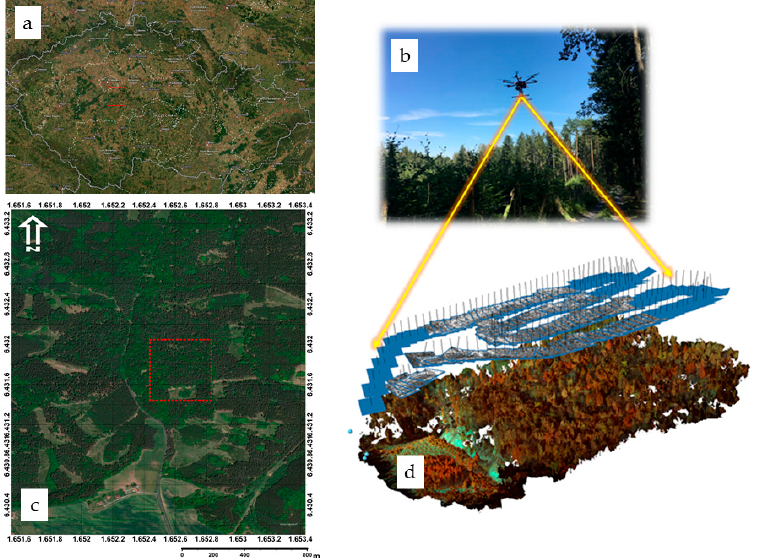
Figure 1. ( a ) Shows the relative location of the study area in the Czech Republic ( b ) the used unmanned aerial system (UAS) DJI S900 embedded with the professional-grade multispectral camera MicaSense RedEdge-M ( c ) absolute location of the study area and ( d ) processed point cloud of the study area in false RGB image for spring 2019 and the applied flight path.